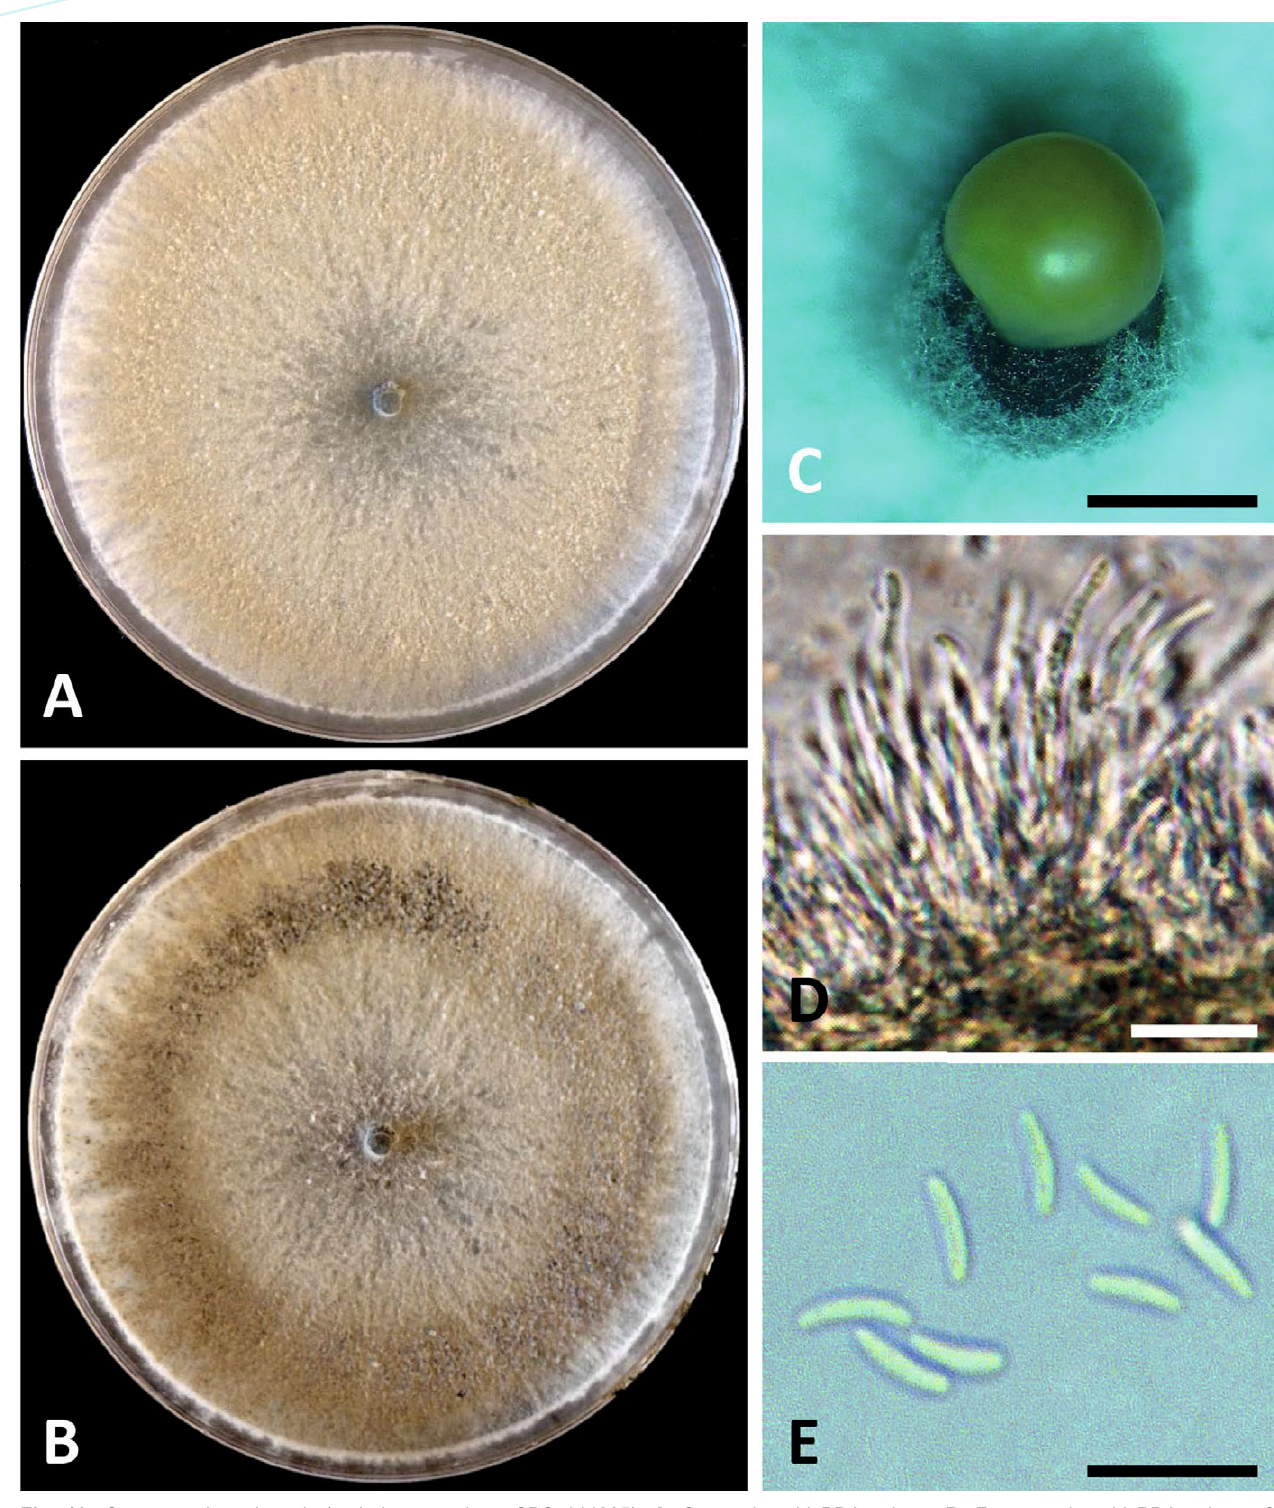
Fig. 10. Cytospora joaquinensis (ex-holotype culture CBS 144235). A. Seven-day-old PDA culture. B. Fourteen-day-old PDA culture. C. Pycnidium. D. (cid:2){(cid:4)(cid:17)(cid:11)(cid:21)(cid:11)(cid:4)(cid:18)(cid:14)(cid:4)(cid:10)(cid:13)(cid:7)(cid:2)(cid:9)(cid:17)(cid:21)(cid:2)(cid:20)(cid:23)(cid:9)(cid:6)(cid:13)(cid:17)(cid:8)(cid:4)(cid:5)(cid:7)(cid:2)(cid:19)(cid:4)(cid:17)(cid:11)(cid:21)(cid:11)(cid:4)(cid:25)(cid:13)(cid:17)(cid:4)(cid:5)(cid:7)(cid:2)(cid:19)(cid:13)(cid:23)(cid:23)(cid:7)(cid:28)(cid:2) E. Conidia. Bars C = 1 mm; D = 20 μm; E = 10